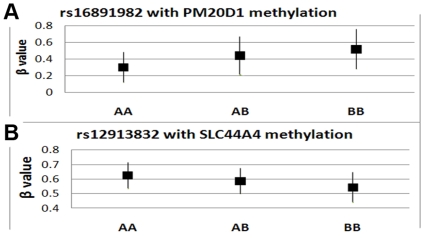
The association of SNPs and DNA methylation.a) rs16891982 positively correlates with the methylation level of PM20D1; minor allele A is associated with lower methylation β values of PM20D1. b) rs12913832 negatively correlates with the methylation level of SLC44A4, i.e. minor allele A is associated with higher methylation β values of SLC44A4.